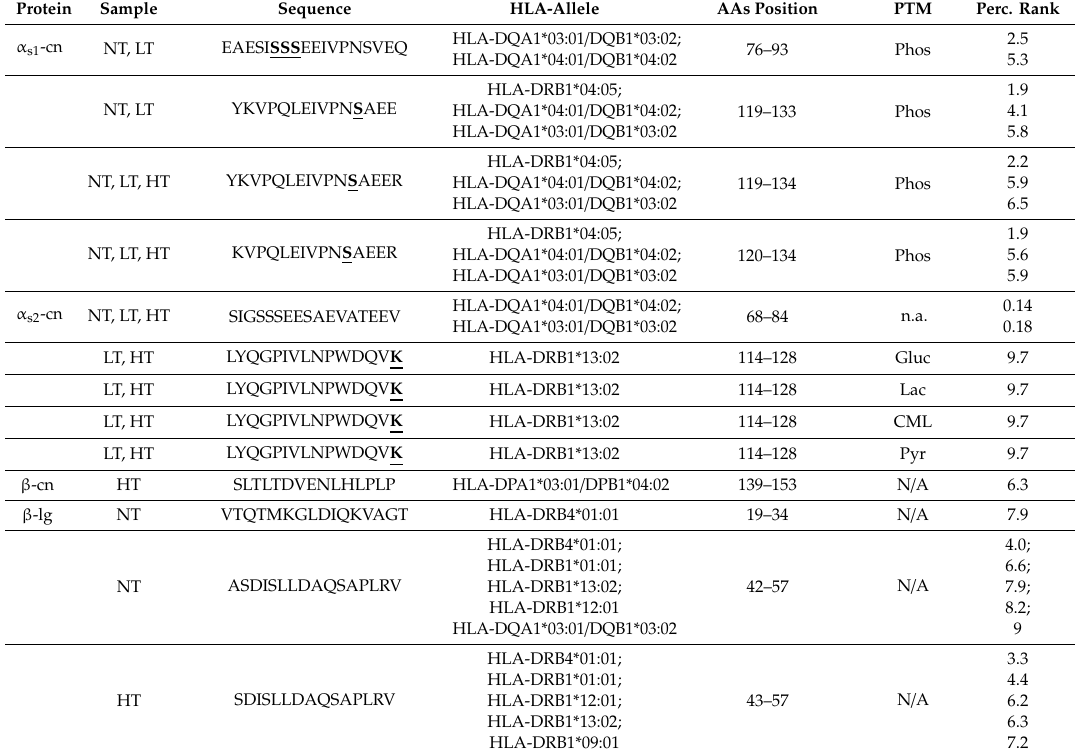
Table 3. Potential T-cell epitopes identified after 10 min in the intestinal phase. Peptides were identified as potential T-cell epitopes using IEDB MHC Class II Binding Prediction software (http: // tools.iedb.org / mhcii / ). Digestion-derived peptides identified from cow’s milk protein, non-treated (NT), dry heated at low temperature (LT), and dry heated at high temperature (HT) applied to simulated infant in vitro digestion, derived from casein (cn) and β -lactoglobulin (lg). Peptides matching exactly the sIgE binding epitope sequence are indicated (*). Amino acids (AAs) position indicates the position within the proteins including the signal peptide. Unmodified peptides and peptides with post translational modifications (PTM), via phosphorylation (Phos), as well as modification to glucosyl lysine (Gluc), lactosyl lysine (Lac), N ε -carboxymethyllysine (CML), and pyrroline (Pyr) were reported. Modified amino acids are highlighted in bold and